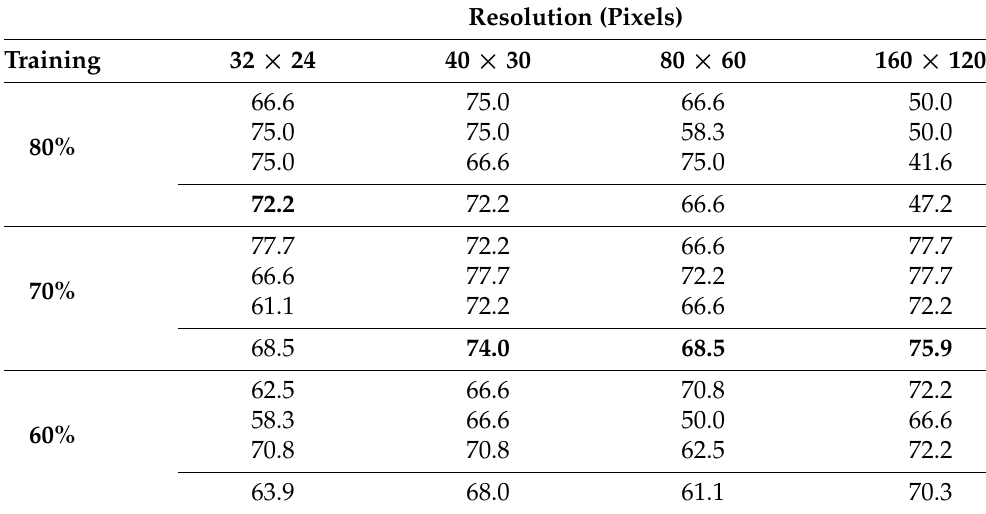
Table 3. Accuracy (%) of the models trained with the 12 different configurations from experiment P02. Each cell presents the accuracy of three independent models per configuration and its average. The best results per resolution are highlighted in bold. Resolution